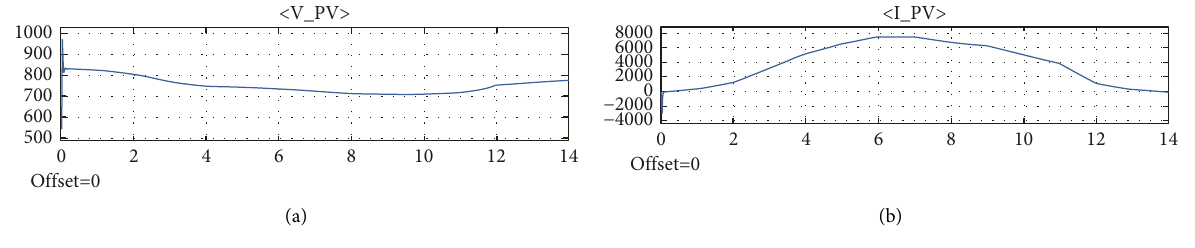
Figure 23: The I-V characteristics for the